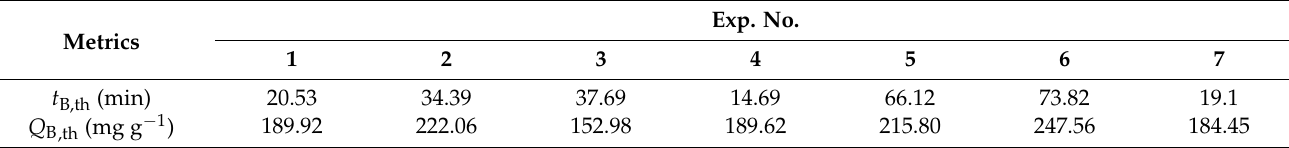
Figure 3. Experimental breakthrough dot plots and dose–response model fitting curves for the seven experiments. Table 3. Adsorption performance metrics of anisole under different